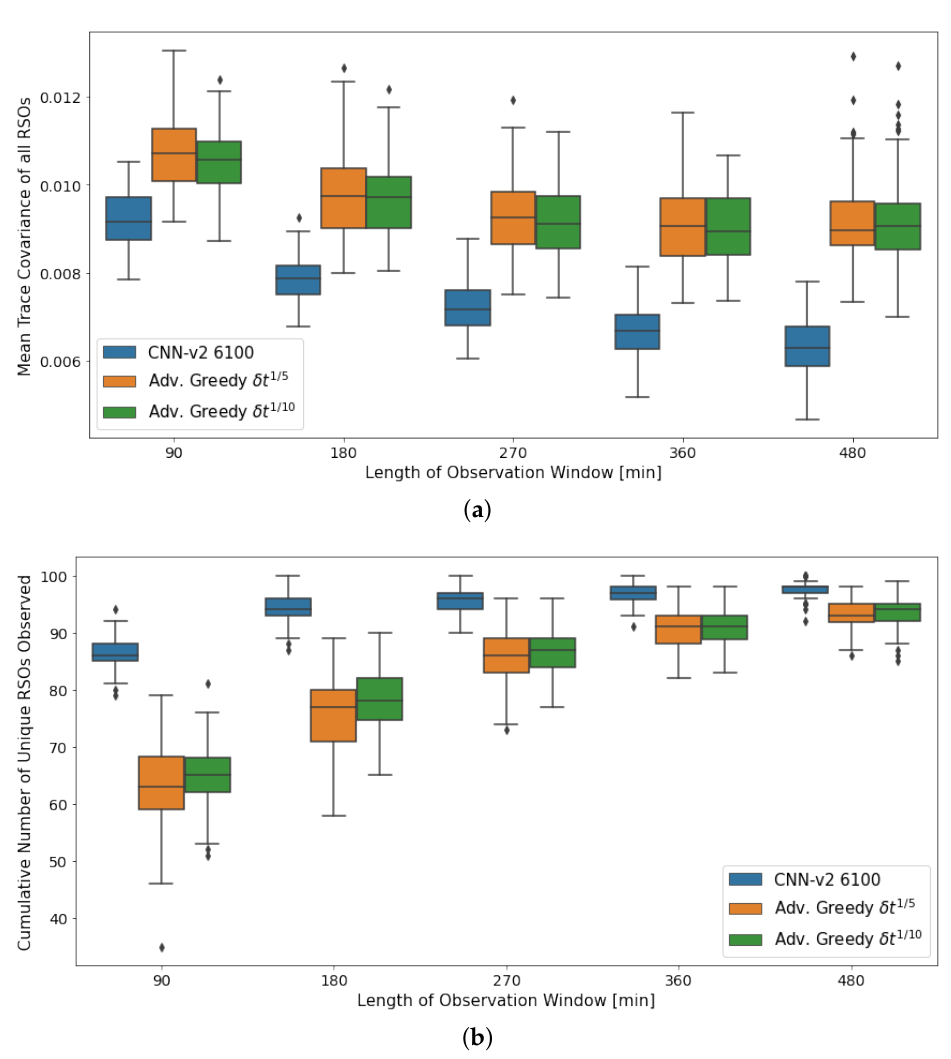
Figure 13. Aggregate performance of the DRL agents with 100 randomly initialized GEO RSOs, evaluated over 100 seeded rollouts of varying observation window length. ( a ) Distribution of the final mean trace covariance at the end of the observation window (lower is better); ( b ) Distribution of the cumulative number of unique RSOs observed at the end of the observation window (higher is better). Note: CNN-v2 6100 represents a CNN-v2 DRL agent trained for 6100 training